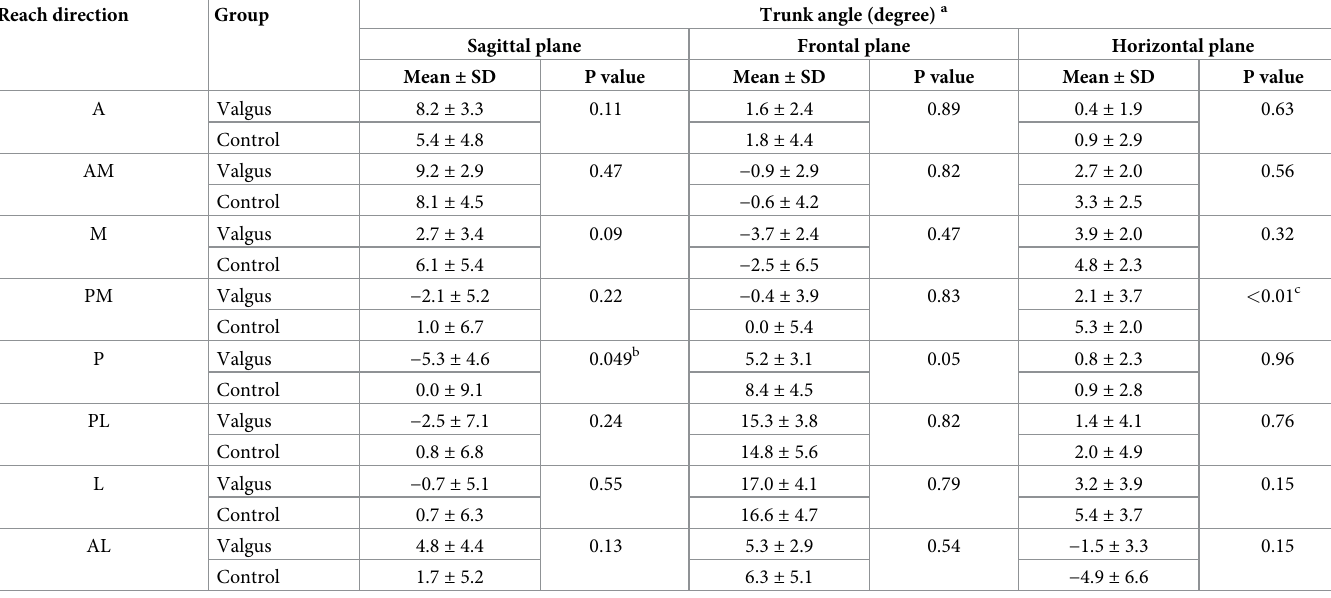
Table 3. The results of trunk angle in all reach directions during Star Excursion Balance